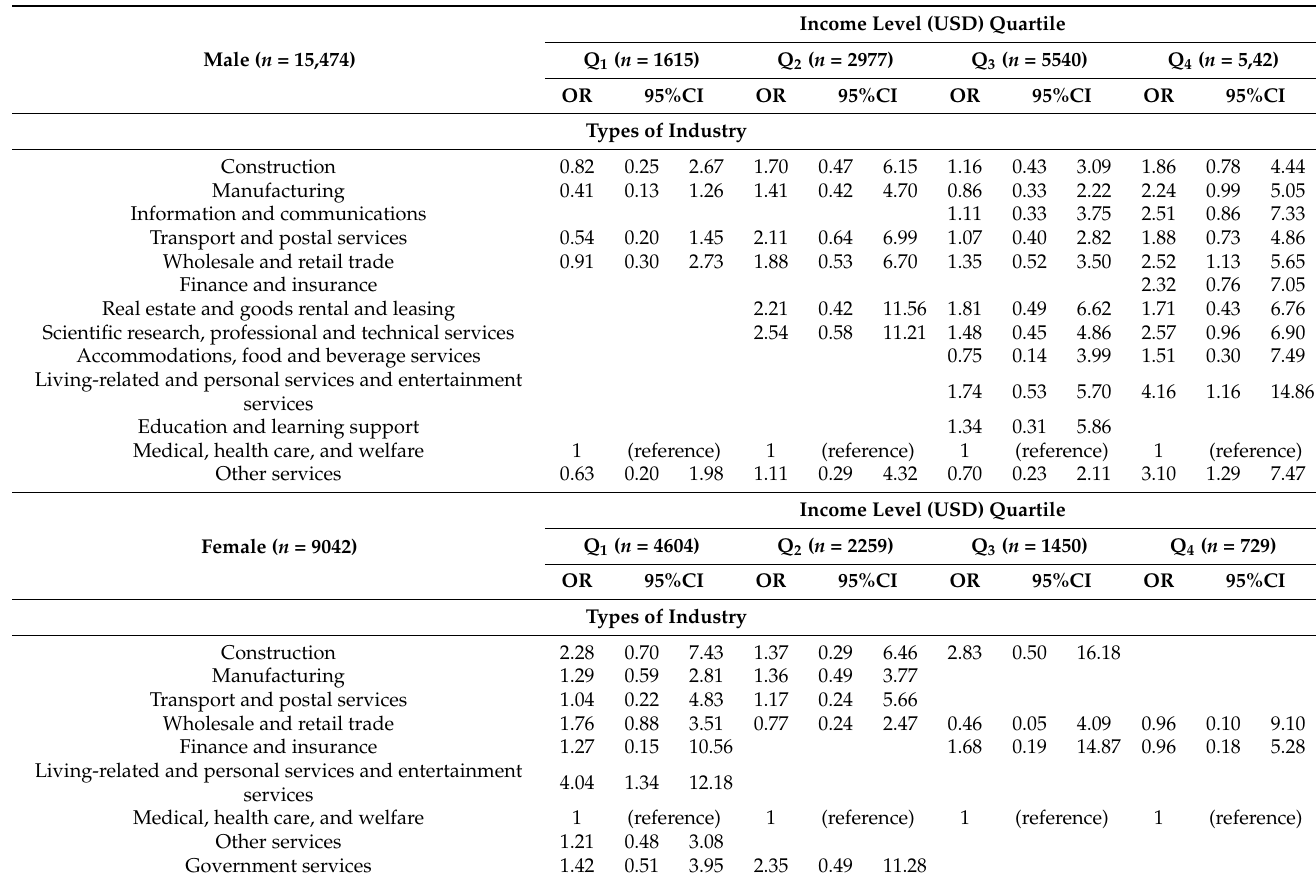
Table 3. Odds ratios and 95% confidence intervals for the onset of diabetes for each industry by income level and